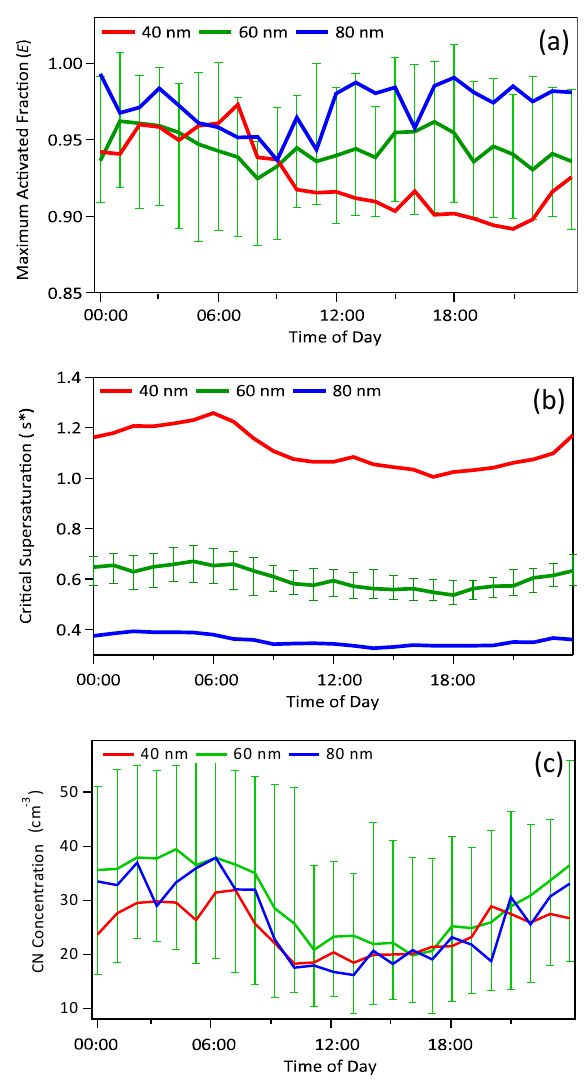
Fig. 6. Diurnal variation of the (a) CCN maximum activated frac- tion, (b) critical supersaturation, and (c) CN concentration for 40, 60, and 80nm particles. Solid lines represent median values. Bars representing the 25th and 75th percentile values are shown for 60nm